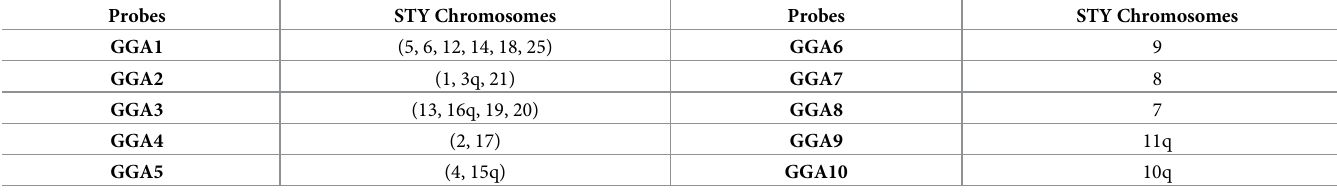
Table 2. Results of hybridizations with G . gallus probes showing the homology between GGA probes in the karyotype of S . tyrannus (STY). Probes STY Chromosomes Probes STY Chromosomes GGA1 (5, 6, 12, 14, 18, 25) GGA6 9 GGA2 (1, 3q, 21) GGA7 8 GGA3 (13, 16q, 19, 20) GGA8 7 GGA4 (2, 17) GGA9 11q GGA5 (4, 15q) GGA10 10q (q = long